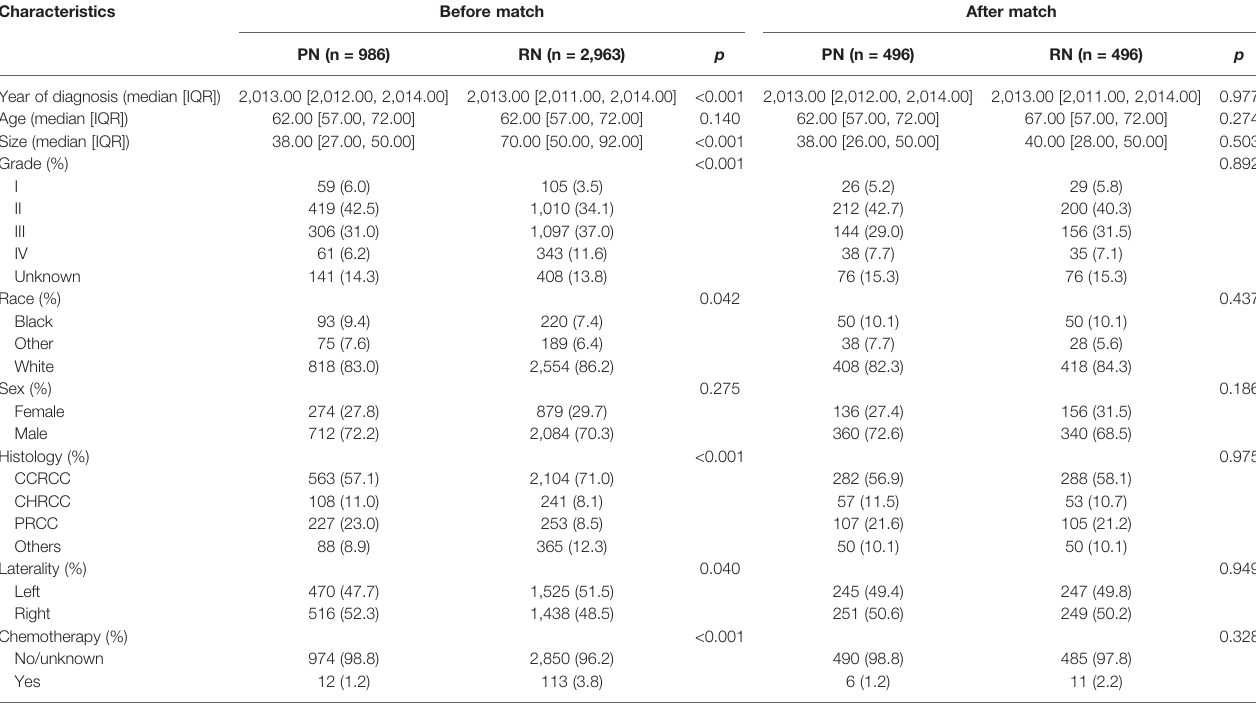
TABLE 2 | Characteristics of fat invasion cohort before and after PSM. Characteristics